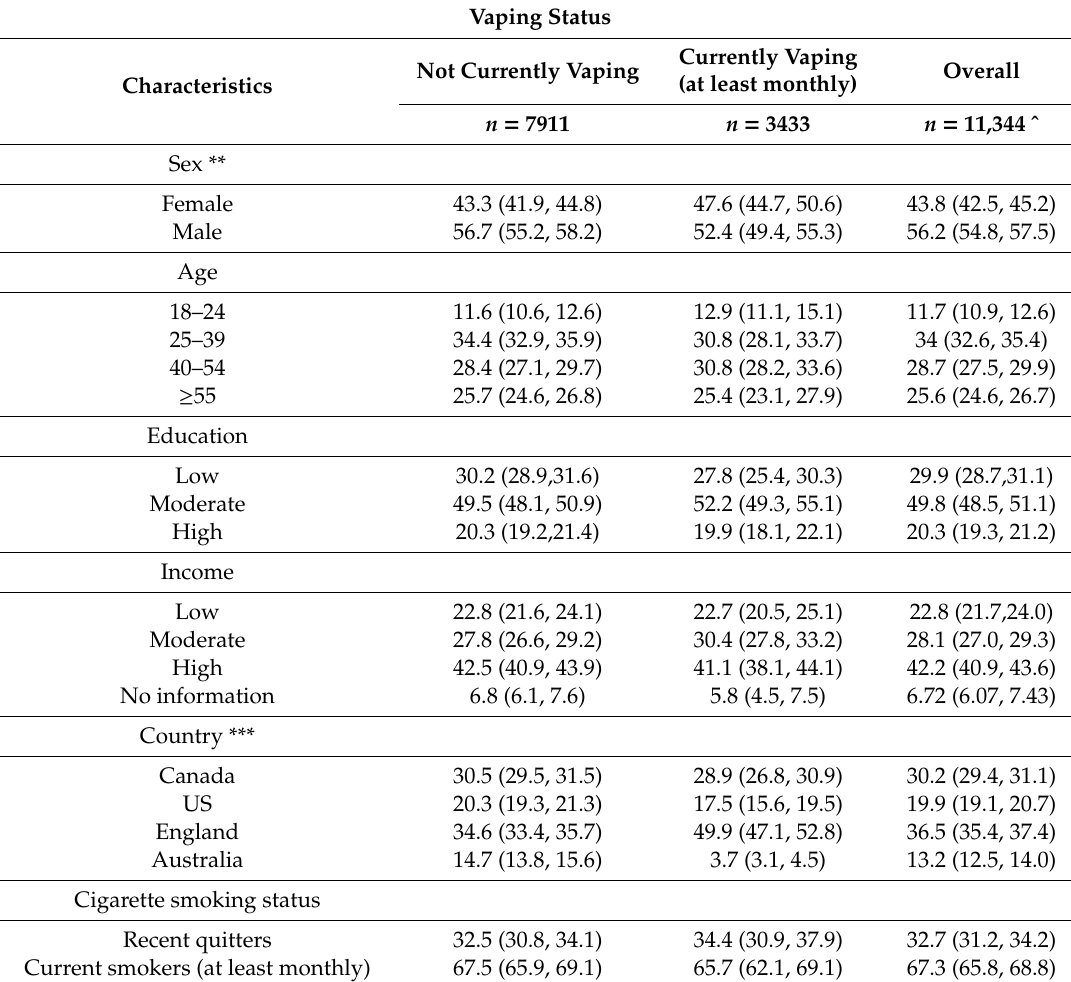
Table 1. Sample characteristics by vaping status, % (95% confidence interval),